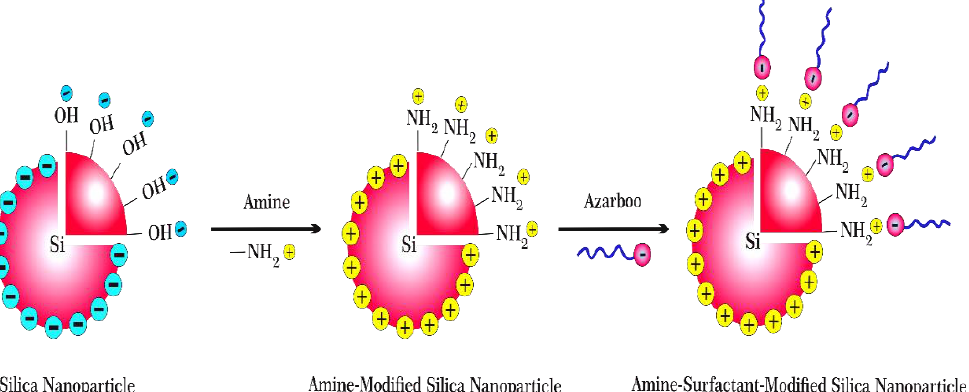
Figure 1. Amine and surfactant modification of silica nanoparticles using Azarboo and amine molecules.